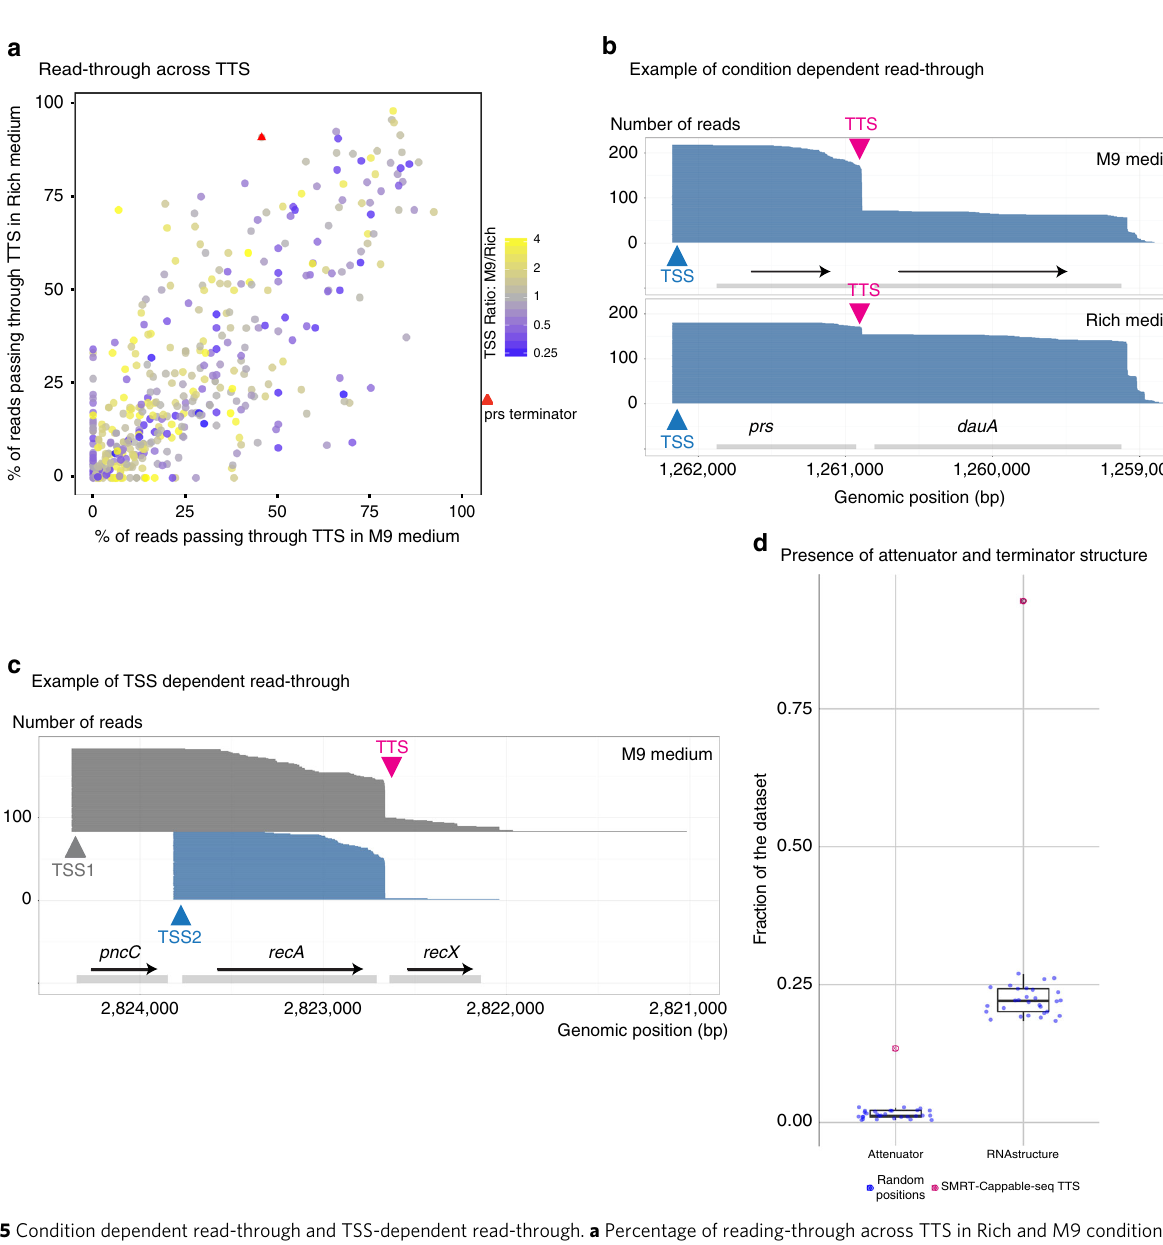
Fig. 5 Condition dependent read-through and TSS-dependent read-through. a Percentage of reading-through across TTS in Rich and M9 conditions. Colors denote the ratio between expression levels of transcripts in M9 vs Rich medium at TSS. b An example of the prs-dauA operon containing a previously known TTS (red arrow), where the rate of read-through is condition dependent. The TTS between the prs and dauA gene shows 91% read-through in Rich medium as opposed to 46% read-through in M9 medium. As a result the dauA gene is up-regulated in Rich medium compared to M9 growth condition despite comparable expression level between conditions for its co-transcribed prs gene. c An example of a TSS-dependent read-through for overlapping transcripts in the same orientations. 32% read-through is observed for the long transcript (TSS1) vs 5% read-through for the short transcript (TSS2). d Percentage of termination sites in M9 medium (red) and random positions (blue) with predicted attenuator structures (left panel) (Pasi fi c algorithm 28 ) and predicted termination loop (right panel). 55 out of 408 termination sites have a predicted attenuator structure, and 386 of 408 termination sites